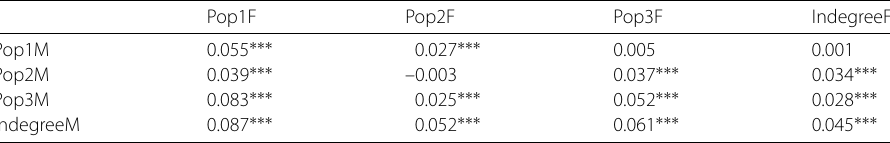
Table 6 Spearman correlation coefficients among centrality indices when males send messages to females Pop1F Pop2F Pop3F IndegreeF Pop1M 0.055 ∗∗∗ 0.027 ∗∗∗ 0.005 0.001 Pop2M 0.039 ∗∗∗ –0.003 0.037 ∗∗∗ 0.034 ∗∗∗ Pop3M 0.083 ∗∗∗ 0.025 ∗∗∗ 0.052 ∗∗∗ 0.028 ∗∗∗ IndegreeM 0.087 ∗∗∗ 0.052 ∗∗∗ 0.061